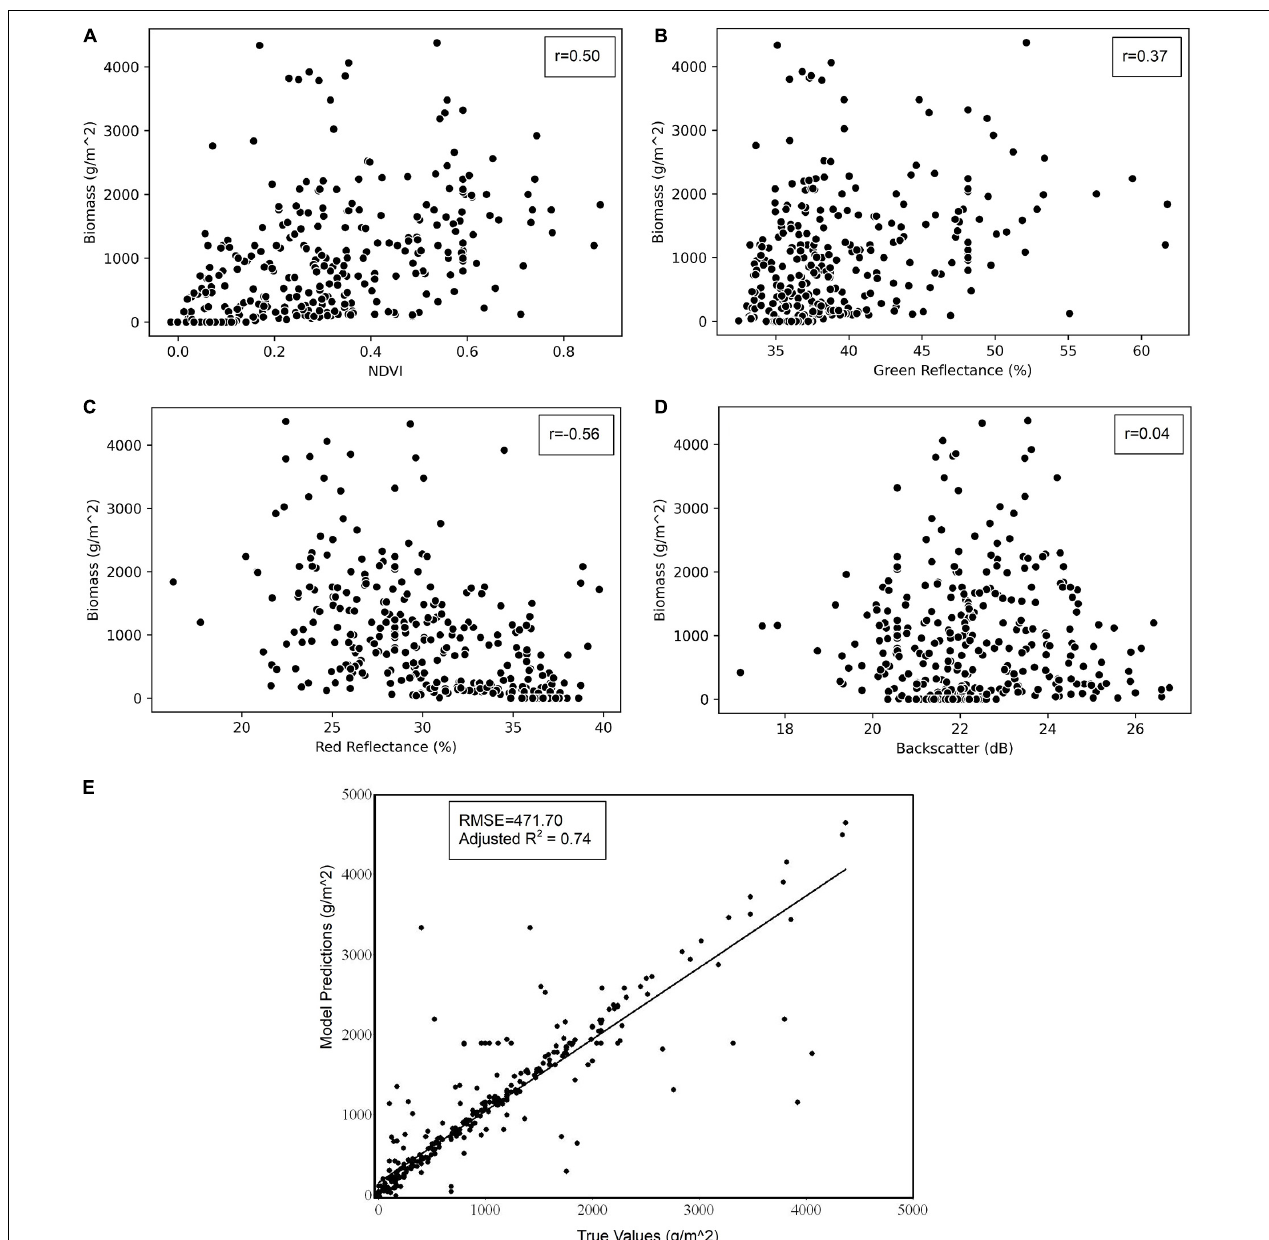
FIGURE 8 | Scatterplots showing the correlation between biomass data from field surveys and other determining variables: (A) NDVI, (B) green reflectance, (C) red reflectance, and (D) radar backscatter. Scatterplot on the bottom (E) shows the field survey biomass data versus the predicted biomass from the ANN